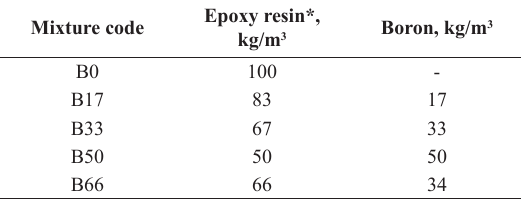
Table 2. Composition of epoxy based polymer composites. Mixture code